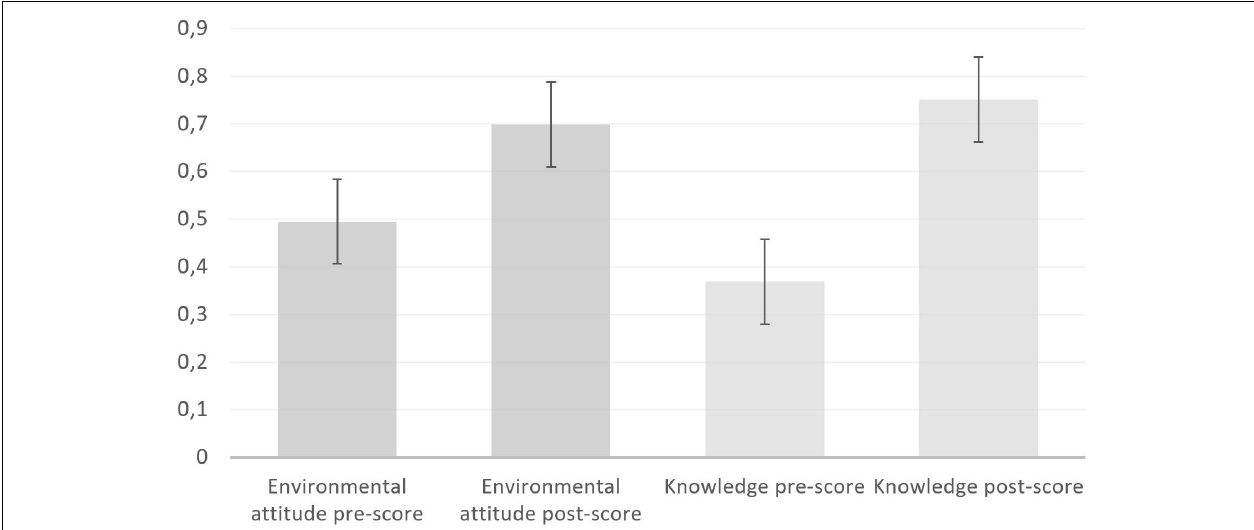
FIGURE 1 | Program effects were statistically significant for environmental attitude and knowledge; error bars indicate 95% confidence intervals. The data were assessed 1 week before and 6–8 weeks after the residential earth education program to determine long-term changes. The Y -axis gives the Rasch calibration output, and the higher the score, the more knowledge is prevalent or the stronger the attitude is.